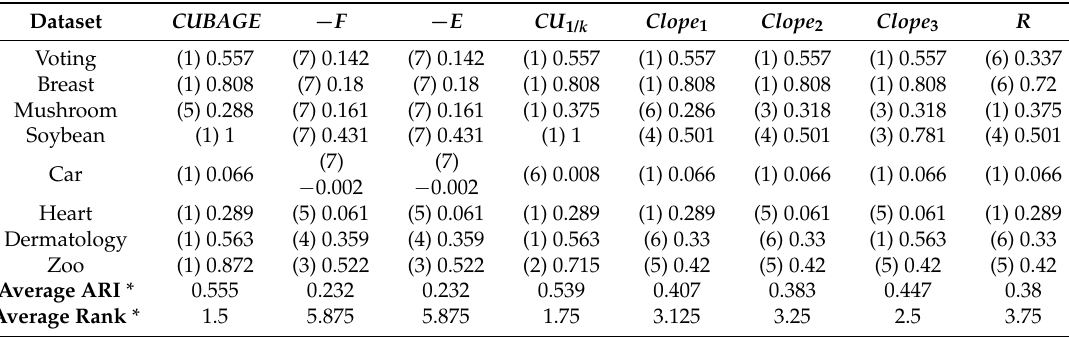
Table 7. Adjusted Rand index (ARI) values of the hierarchical partitions chosen from layers 2–10 by each internal CVI.